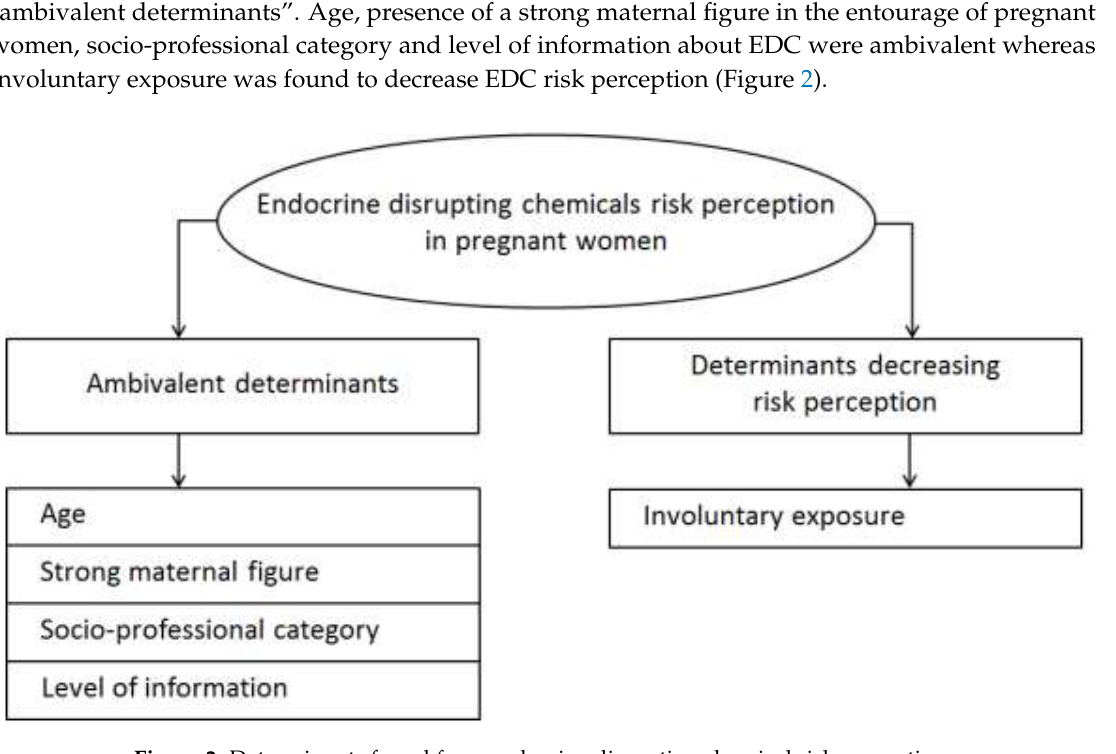
Figure 2. Determinants found from endocrine disrupting chemical risk perception.